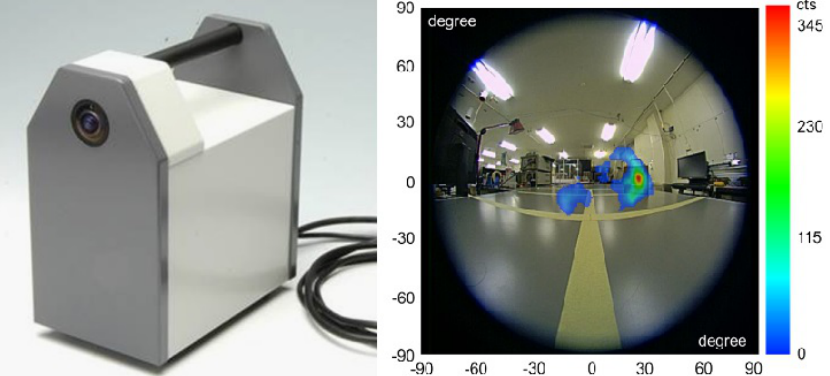
Figure 12. Handheld Compton camera using Ce:GAGG scintillation crystals ( left ) and reconstructed image of a 137 Cs source ( right ). These figures were published in Reference [22]; copyright Else- vier